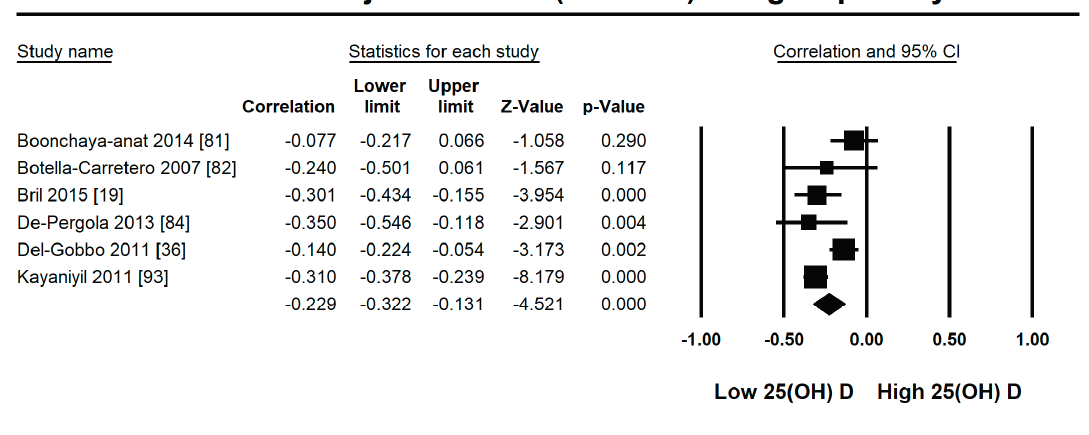
Figure 8. Forest plot for the medium BMI quartile (25–30) of non-diabetic subject studies showing the correlation between the status of vitamin D and fasting plasma insulin. The random effects model was used for the determination of correlation and 95% CI [57,76,77,79,80,83,86,88,89,94,95,97–99,102].